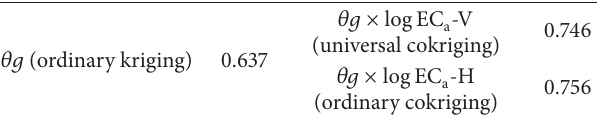
Table 7: Correlation coefficients between measured gravimetric water content and data estimated by kriging and